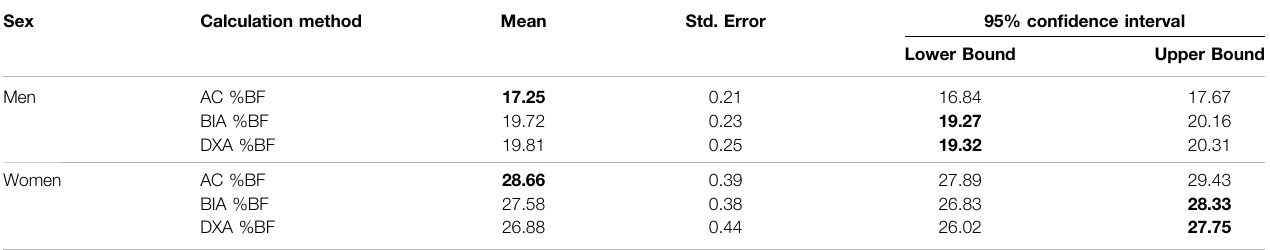
TABLE 2 | Within-subjects effects between %BF calculation methods.